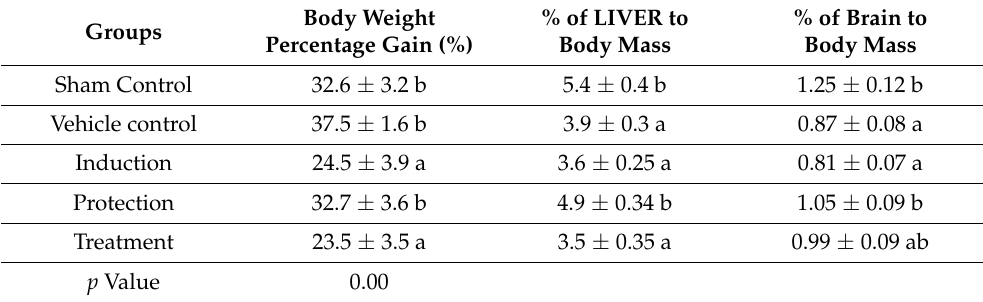
Table 2. The effect of different treatments on body weight gain and liver or brain-to-body mass